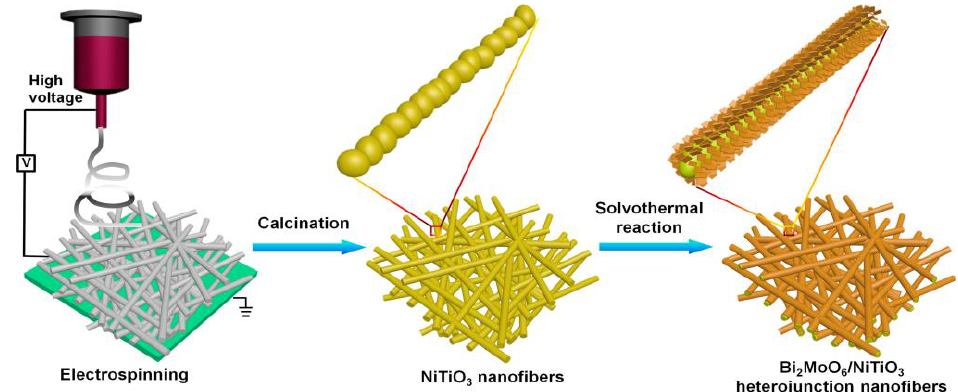
Figure 13. Electrospinning preparation of Bi 2 MoO 6 /NiTiO 3 nanofibers [105]. The magnetite polypyrrole core-shell (Fe 3 O 4 @PPY) immobilized NiS nano-photocata-